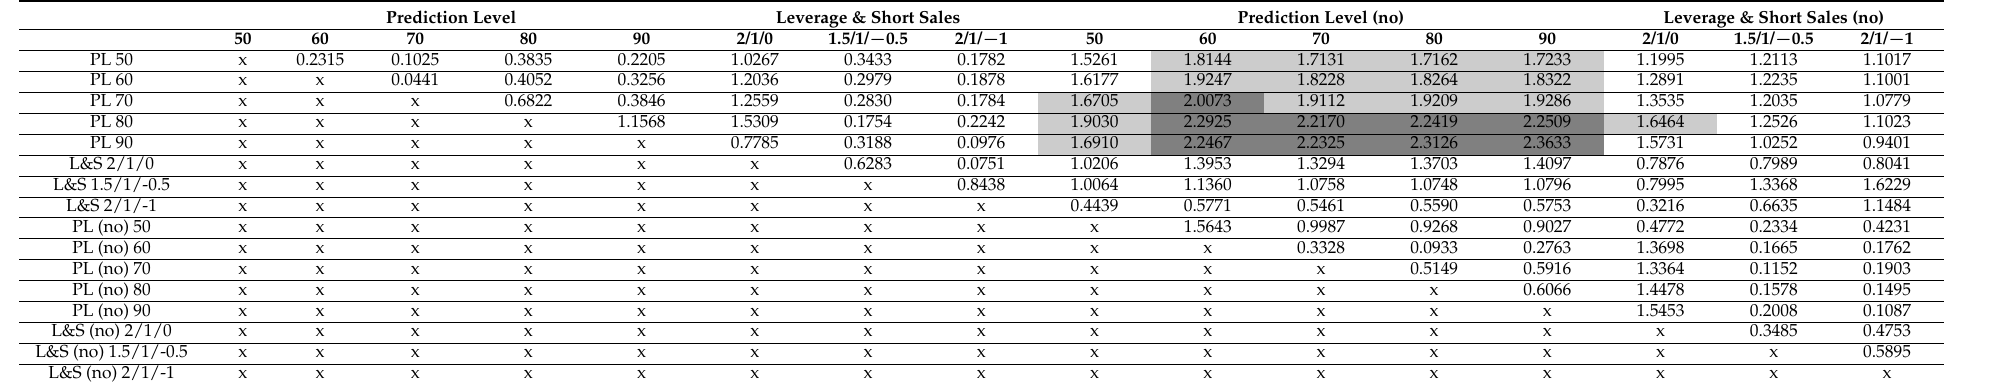
Values marked in dark gray are significant for level 5% (test statistic: 1.96), while light gray ones are significant for level 10% (test statistic: